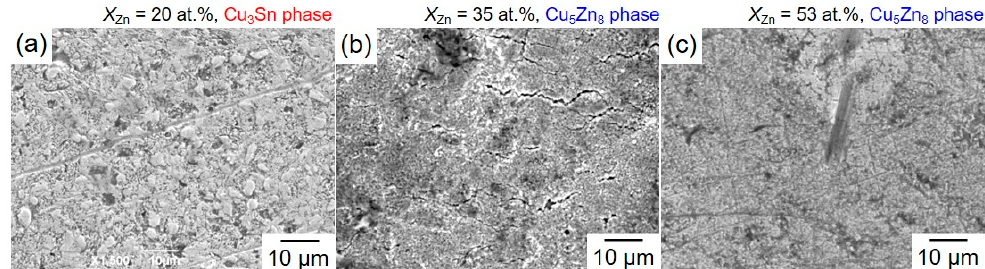
Figure 11. SEM images of the fracture surface of the solder-jointed copper rods with Sn-Zn alloy films (Zn content; ( a ) 20 at.%, ( b ) 35 at.%, ( c ) 53 at.%).